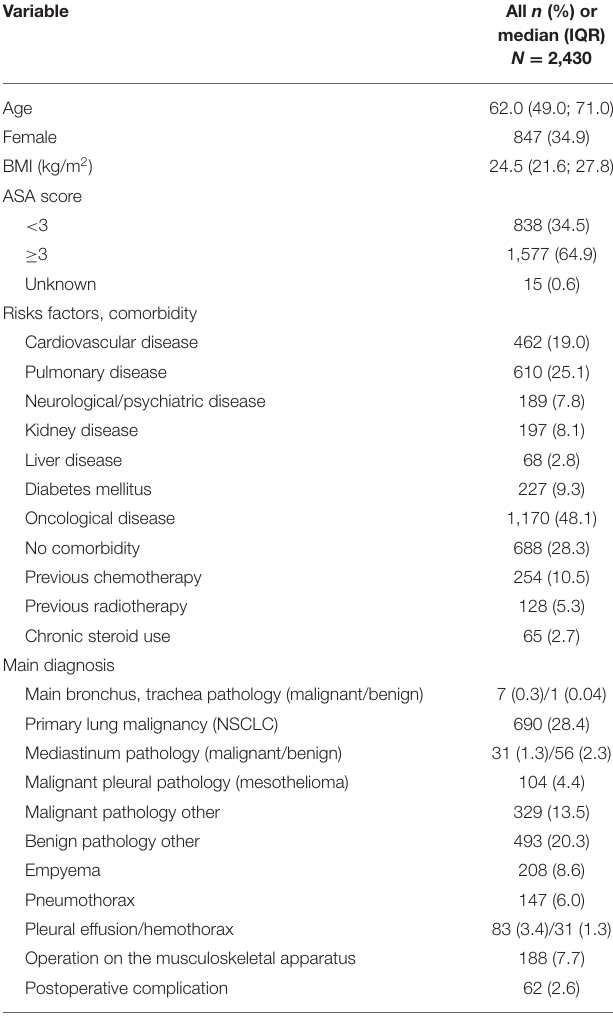
TABLE 1 | Clinicopathological characteristics of 2,430 patients undergoing a thoracic surgery.